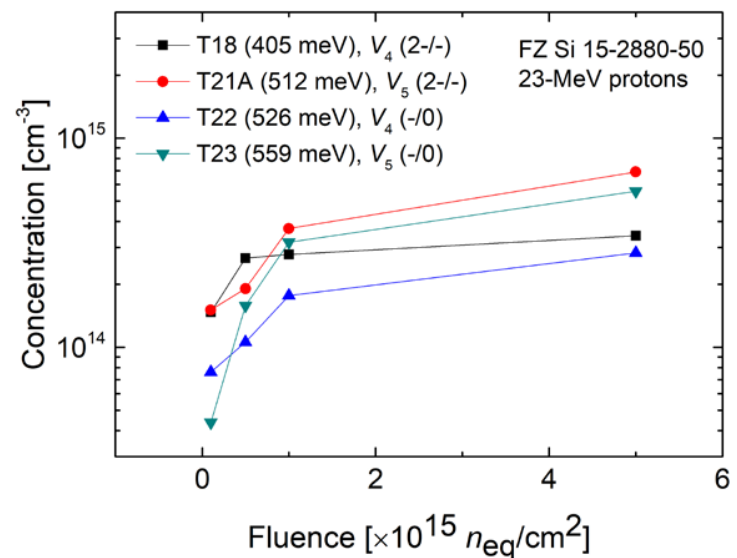
Figure 6. Variation in the concentrations of the T18 and T22 traps, attributed to the (2− / −) and (−/0) charge state changes of tetravacancies, respectively, as well as those of the T21A and T23 traps, attributed to the (2− / −) and (−/0) charge state changes of pentavacancies, respectively, with an increase in the fluence from 1×10 14 to 5×10 15 n eq /cm 2 during the irradiation of HPSi samples with 23 - MeV protons.